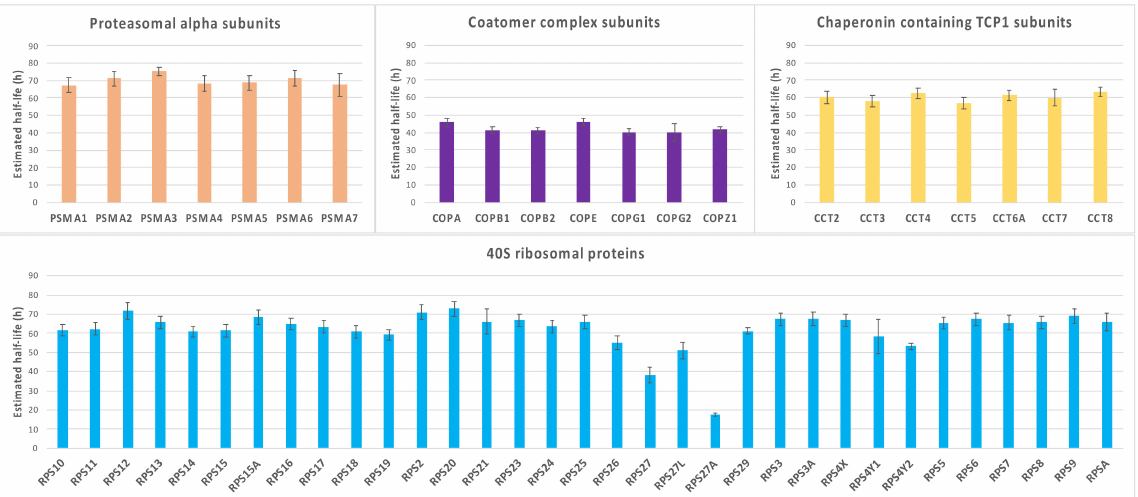
Figure 8. Half-lives of proteins belonging to selected macromolecular complexes. The graphs show the estimated half-lives for proteins that are part of specific, well-characterized macromolecular complexes. Error bars indicate standard